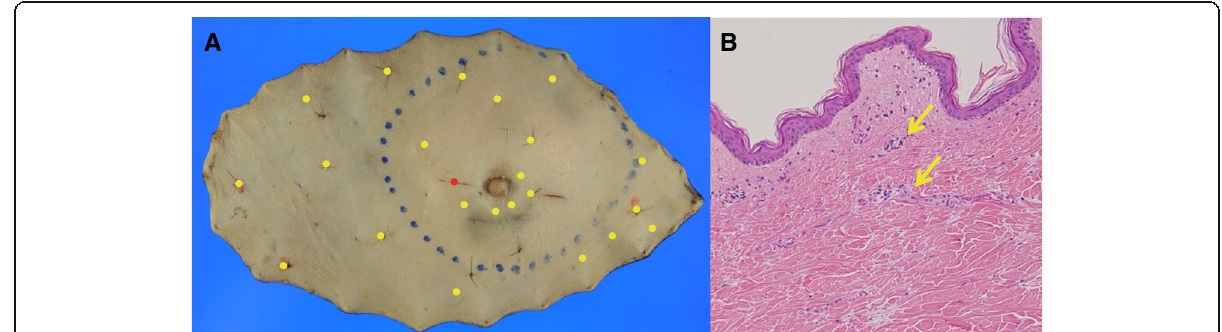
Fig. 4 Macroscopic findings of mapping biopsy and pathological examination (case 2). a A red dot indicates the surgical trace. Yellow dots indicate locations at which atypical endothelial cells were observed. b Atypical endothelial cells, in which the degree of atypia was less than that of the primary tumor (H.E. staining: × 20). Arrow: atypical endothelial